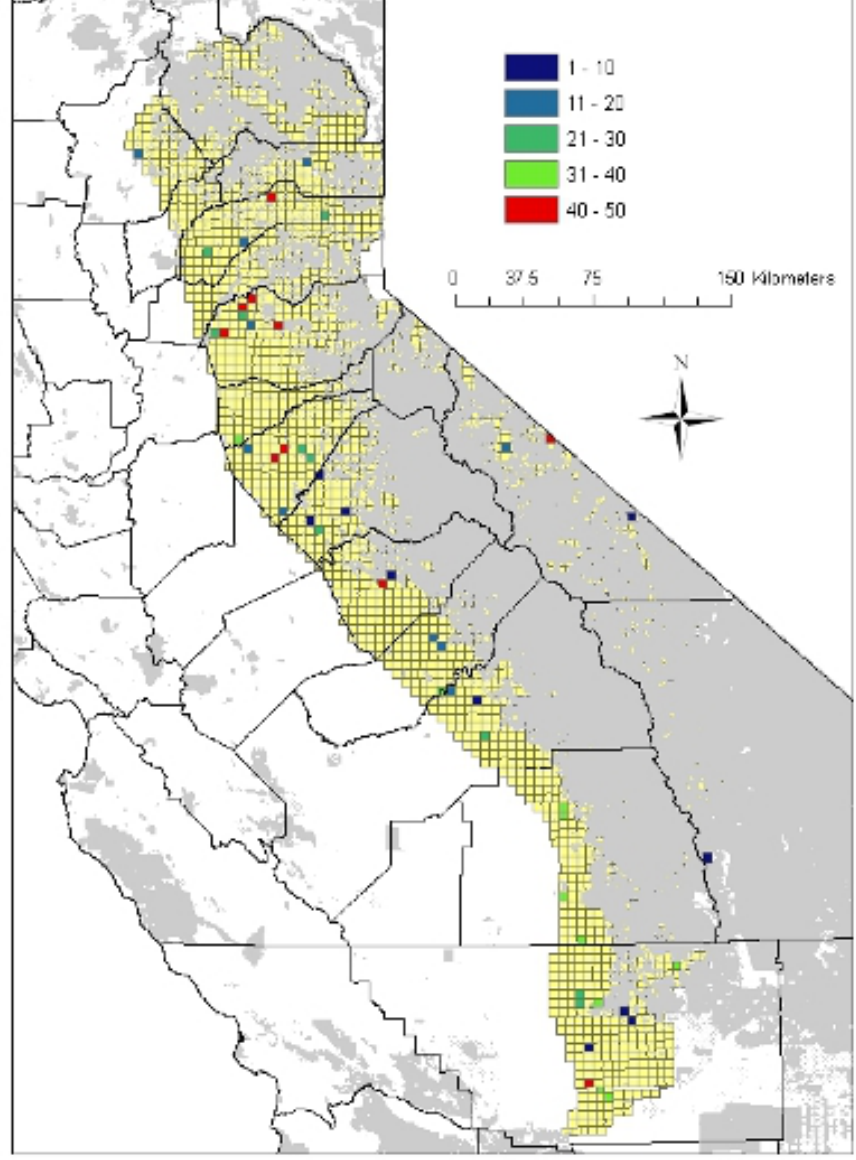
Fig. 11. A portfolio of 50 sites selected by the greedy algorithm and a budget of $144 million. The color indicates the order of site selection with sites 41-50 being the last 10 selected. County boundaries are drawn, and existing public and private reserved lands are shown as a gray